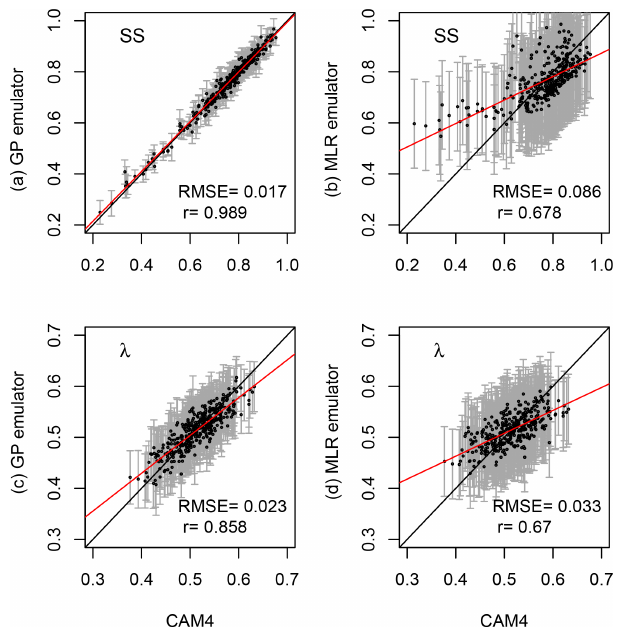
Figure 3. Points show predictions from the emulator ( y axis) against CAM4 simulated values ( x axis) for SS (a) and λ (b) for each case in the n = 350 training set, using the statistical emulator in LOOCV mode (see Sect. 4.1). Panels (a) and (c) show predic- tions made using the GP emulator, and the panels (b) and (d) show predictions made using the MLR emulator. Gray error bars show the 95% prediction interval for each case. The red line is a least- squares linear fit of the predicted against simulated values, and the black solid line shows the 1 : 1